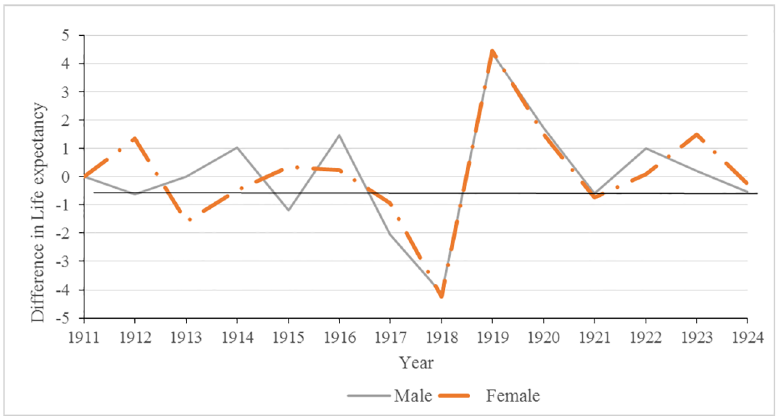
Fig 3. Male and female changes in annual life expectancies at 25 years of age: Malta 1911–1924.